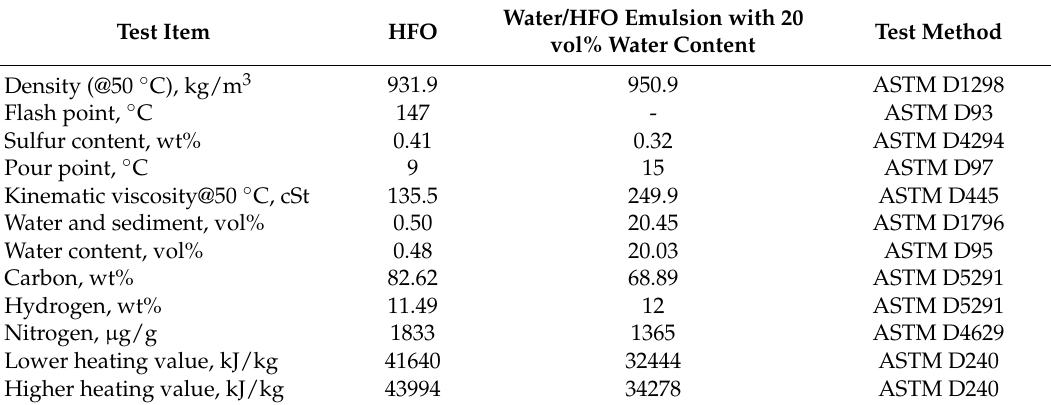
Table 1. Properties of the heavy fuel oil (HFO) and water/HFO emulsion with a 20 vol% water content.